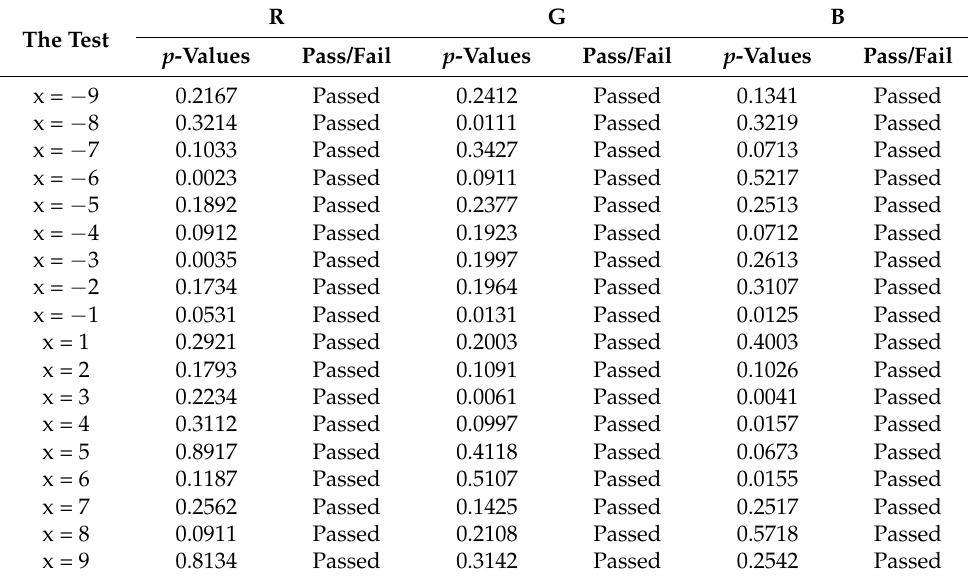
Table 16. Random excursions variant test.